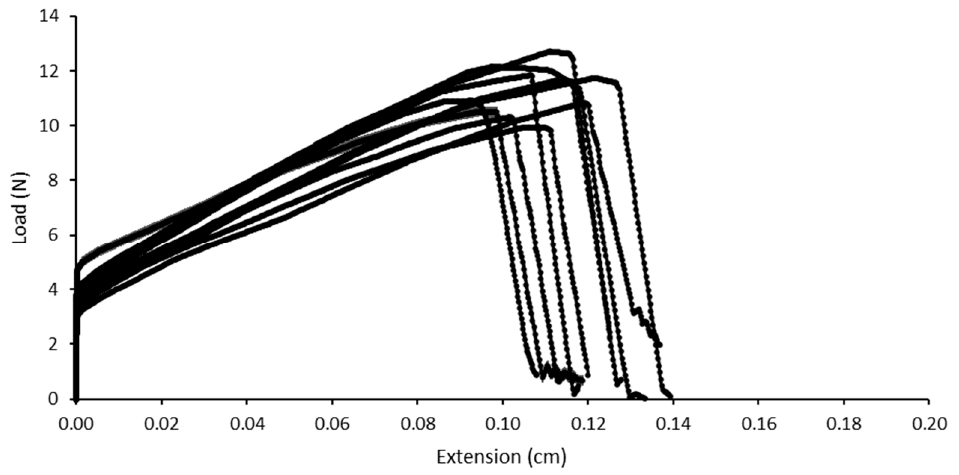
Figure 9. Force-path diagrams of 10 individual samples of a PVA yarn produced using a fully moisture encapsulated melt extrusion system followed by direct spinning. The yarn material was stored for 12 months at room temperature on desiccant packed in polyethylene bags.